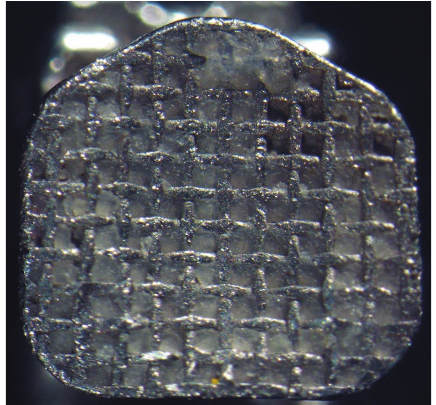
Figure 2: Damon 3MX bracket, single